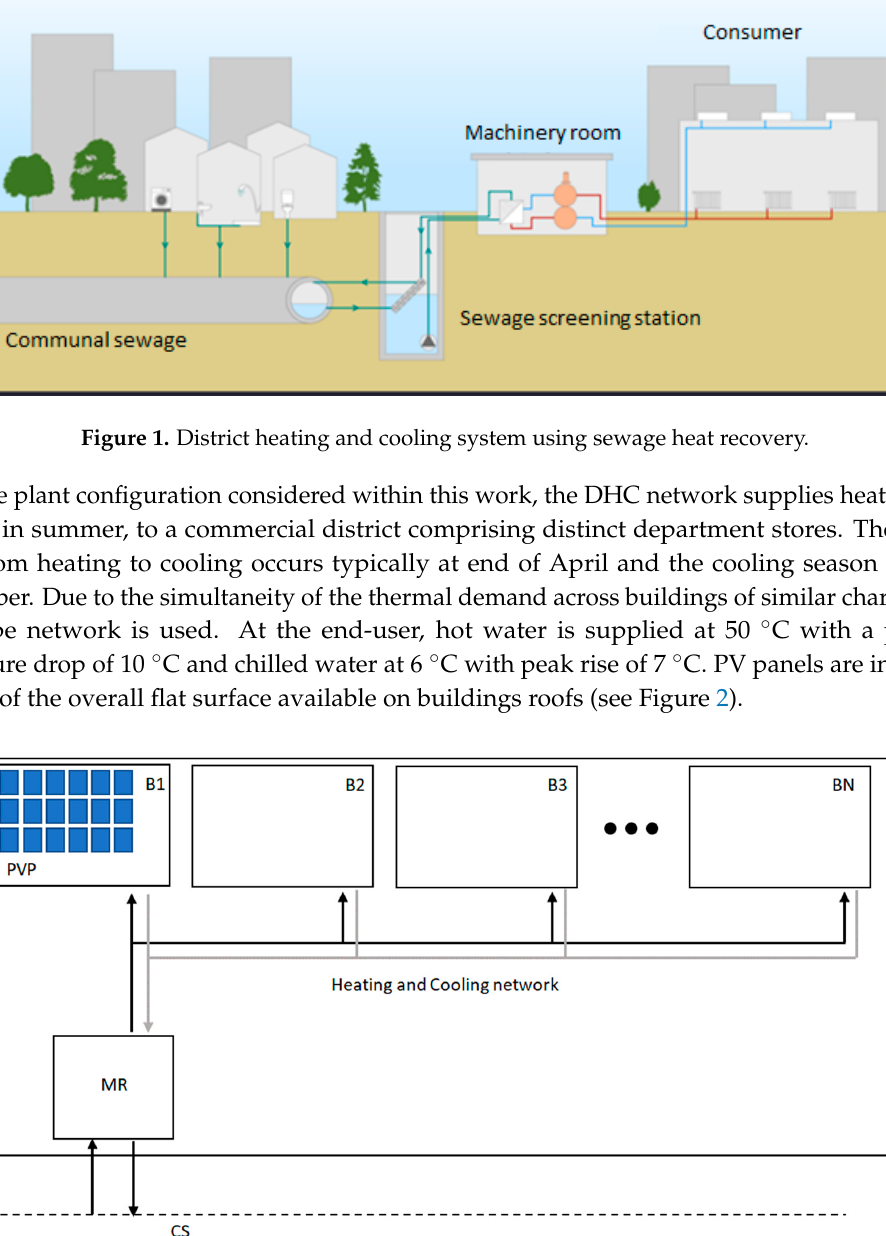
Figure 2. DHC system layout: communal sewage (CS), machinery room (MR), photovoltaic plant (PVP), buildings (B1, B2, B3, …, BN).